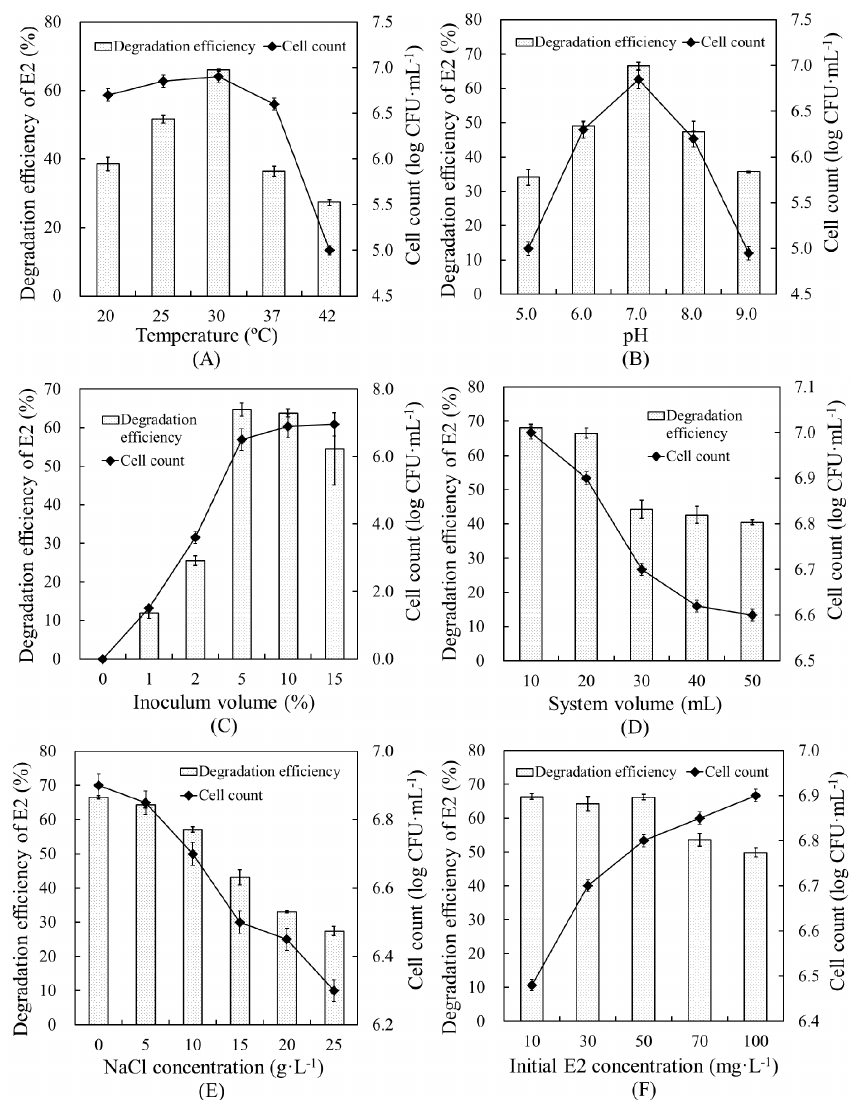
Figure 4. Effects of environmental parameters on E2 removal in EMM by strain E2S: ( A ) temperature, ( B ) pH; ( C ) inoculum volume; ( D ) system volume; ( E ) NaCl concentration; and ( F ) initial E2 concentration. The error bars represent standard deviations.